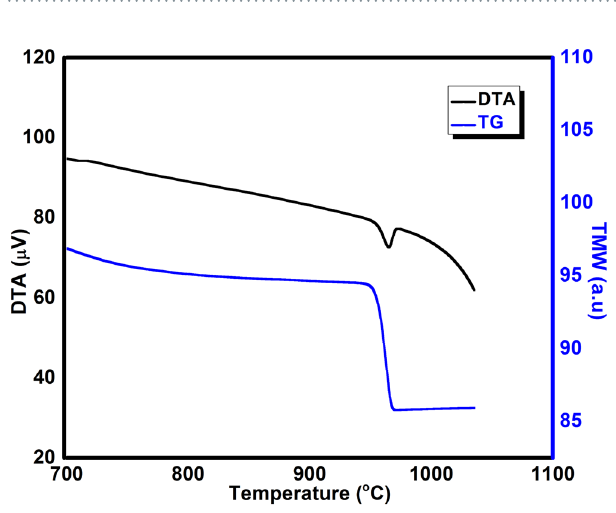
Table 1. Positron lifetimes with corresponding intensities for Fe, Co and FeCo.